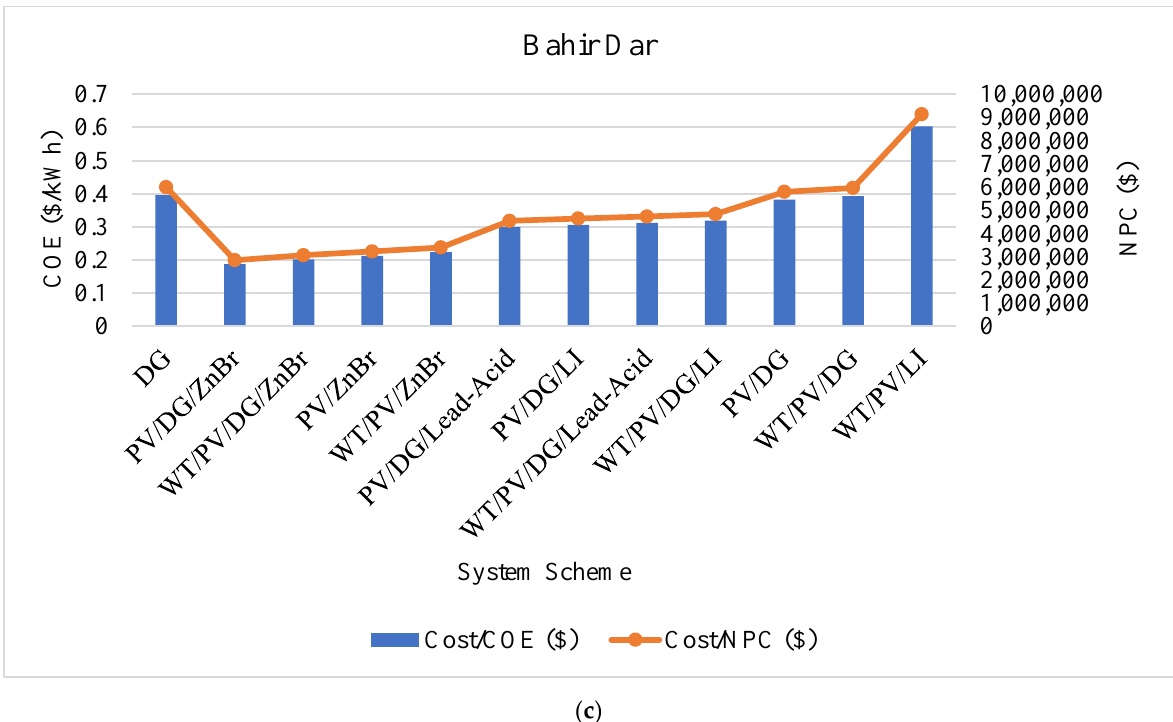
Figure 9. Feasible configurations in three cities, ( a ) Addis Ababa, ( b ) Jijga and ( c ) Bahir Dar.